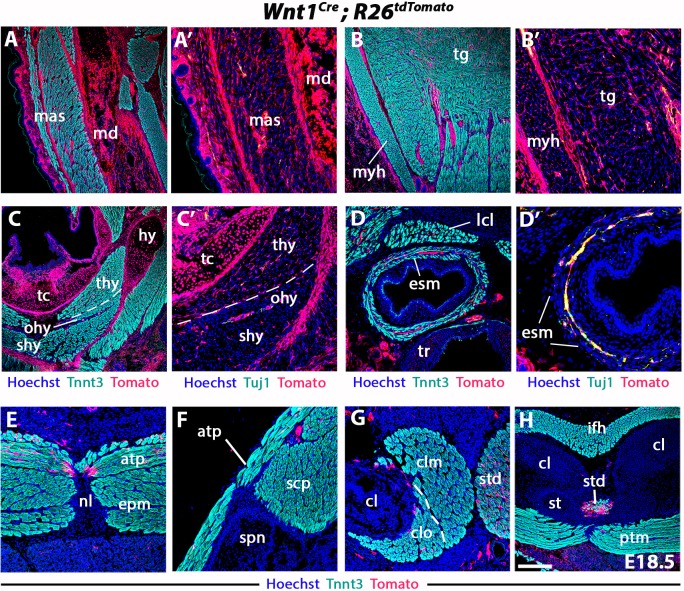
Neural crest contribution to neck and pectoral structures.Contribution of Wnt1-derived NCCs to connective tissue of branchiomeric (mas, myh, esm) and somitic muscles (tg, ifh, ptm, epm, scp) (refer to Figure 3, n = 2) (A–H). Note that the esophagus (esm) and infrahyoid (thy, ohy, shy) muscles show little or no NCC contribution to connective tissue (C–D’). Only few Wnt1-derived cells are present at connection sites of cucullaris-derived muscles on the pectoral girdle (E–H). atp, acromiotrapezius; cl, clavicle; clm, cleidomastoid; clo, cleido-occipitalis; epm; epaxial neck musculature; esm, esophagus striated muscle; hy, hyoid bone; ifh, infrahyoid muscles; lcl, longus colli; mas, masseter; md; mandible; myh, mylohyoid; nl, nuchal ligament; ohy, omohyoid; ptm, pectoralis muscles; shy, sternohyoid; spn, scapular spine; scp, scapular muscles; st, sternum; std, sternomastoid; tc, thyroid cartilage; thy, thyrohyoid; tg, tongue; tr, tracheal ridge. Scale bars: in H for A-C, H 100 µm, for A’-C’, D-G 200 µm; for D’ 400 µm.